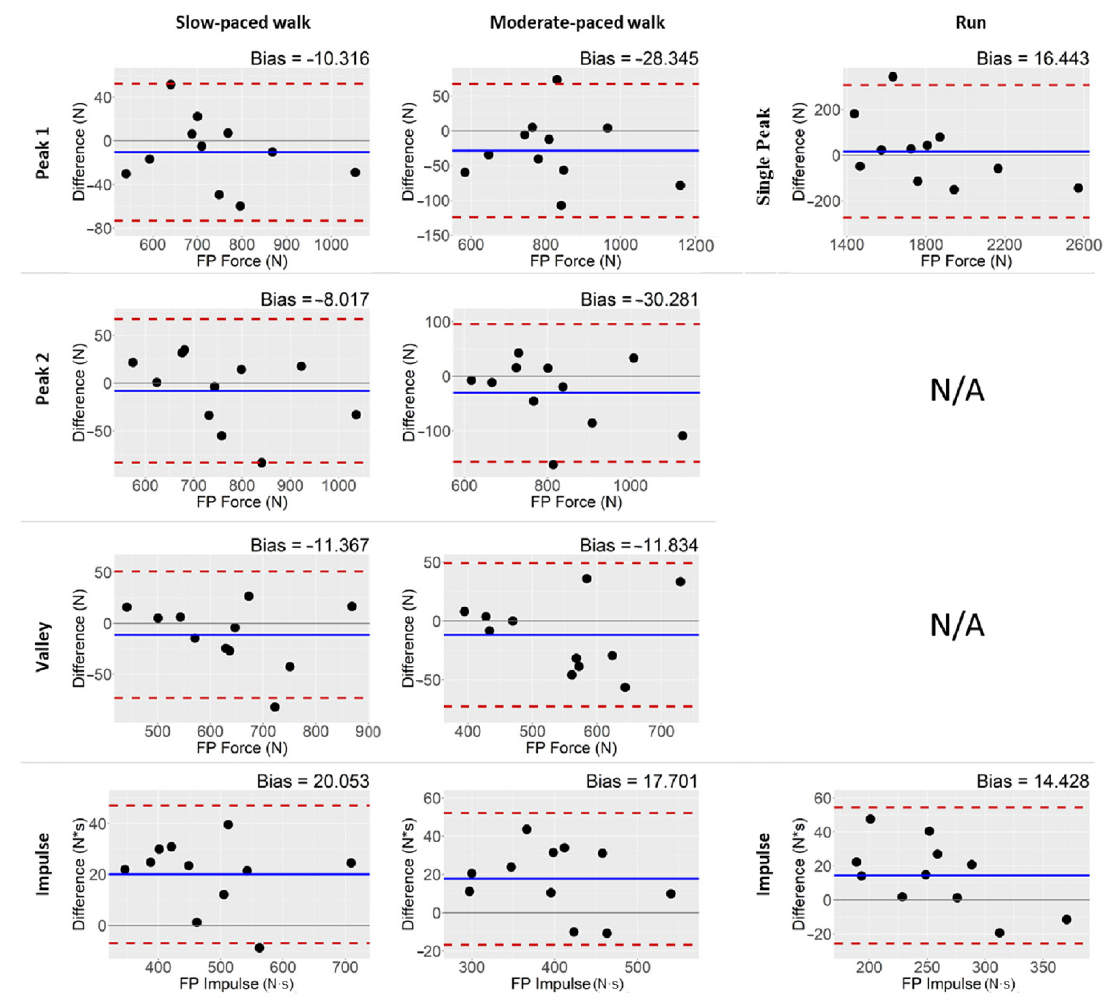
Figure 2. Modified Bland–Altman plots of Visit 1. The difference in mean force measures for each subject between the “gold standard” force plate and Insole3 is plotted. The mean bias is indicated by a solid blue line, and upper and lower limits of agreement are indicated by dashed red lines. Absolute biases are indicated at the top of each plot. Each point represents each subject ( n = 11).